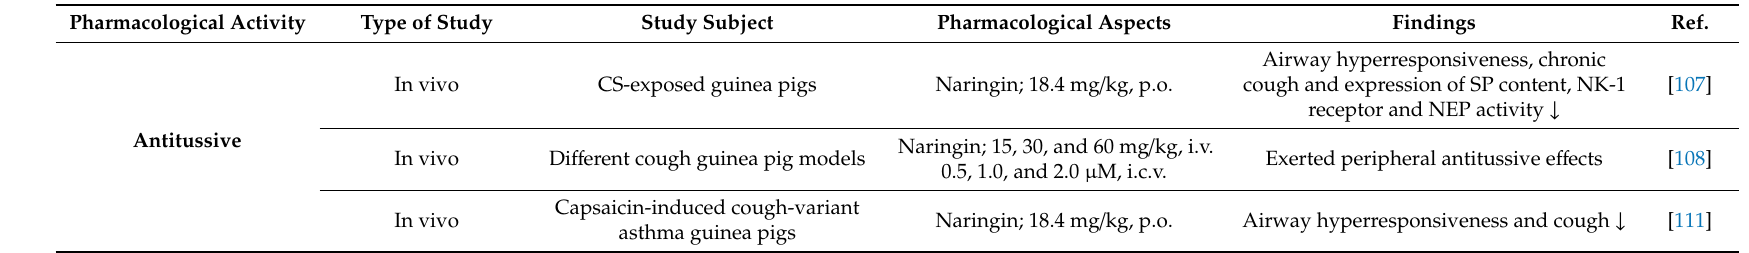
Table 6. Summary of antitussive e ff ects of naringenin and